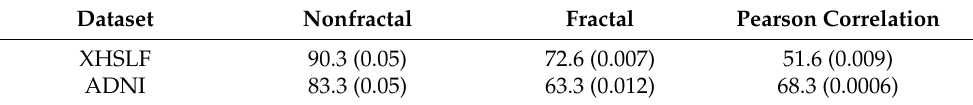
Table 4. Accuracy (in %) of the subspace discriminant ensemble classifier using 820 top-most significant connections for XHSLF dataset and 630 top-most significant connections for ADNI dataset of nonfractal, fractal and Pearson correlation. The value in the bracket is the p -value at 820 (XHSLF) or 630 (ADNI) top-most significant